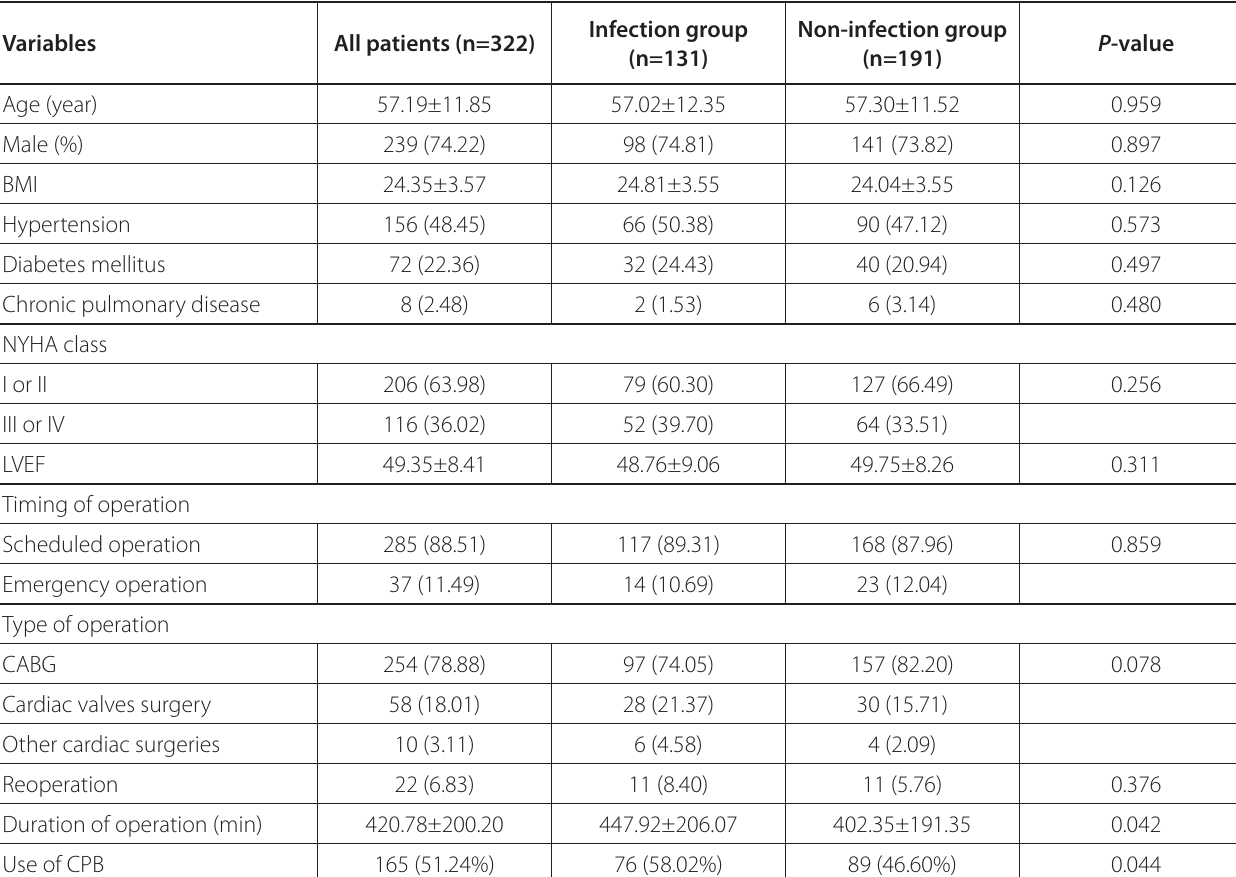
Table 1 . Baseline characteristics of ECMO